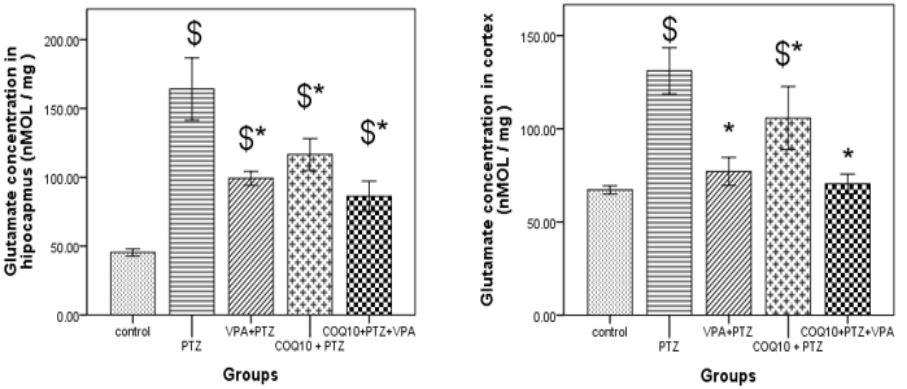
Figure 4. Effect of the test drugs on the glutamate level in the hippocampus and cortex of rats sub- jected to PTZ kindling. The data are expressed as the mean ± the standard error of the mean ( N = 6), one-way ANOVA, and post hoc Tukey’s test. COQ10: Coenzyme Q10; PTZ: Pentylenetetrazole; VPA: Valproic acid. $ p < 0.05, compared to the control group; * p < 0.05, compared to the PTZ group alone.